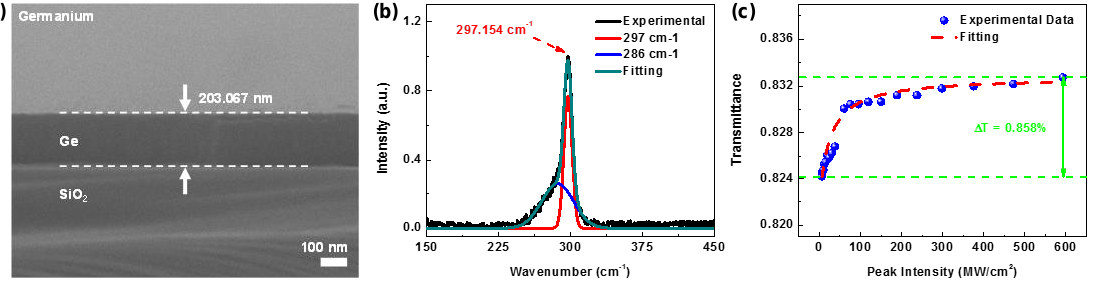
Figure 3. ( a ) FESEM images and ( b ) the Raman spectrum ( c ) the nonlinear transmittance of the germanium thin-film deposited by the PECVD.